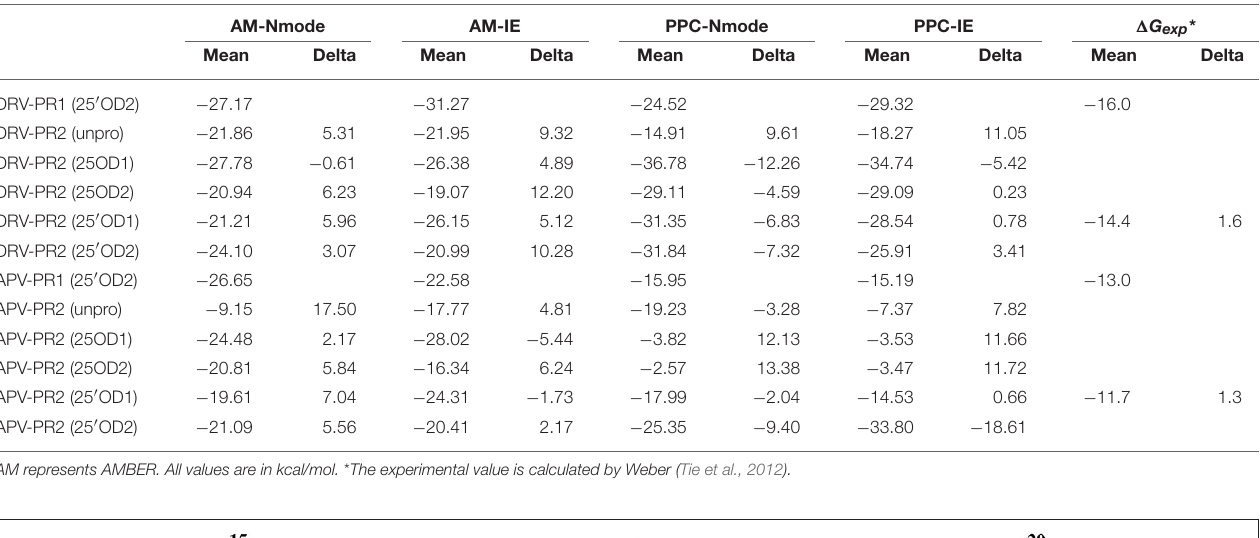
TABLE 2 | Binding free energy and delta of PR1 and PR2 complexes.